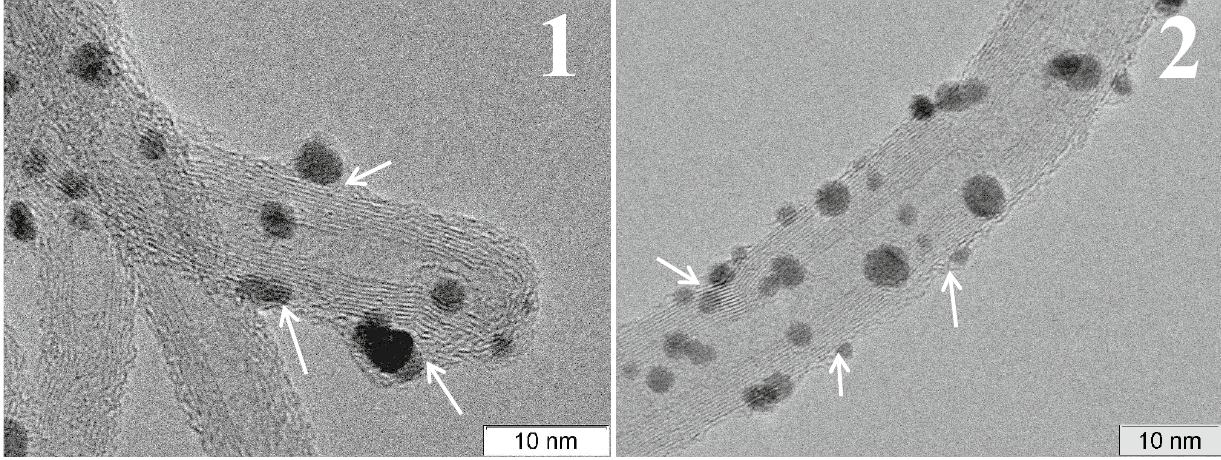
Fig. 4 TEM micrographs with high magnification of the catalysts: Pt/CNT-M (1) and Pt/CNT-MF (2). Arrows show the film of melam (1) and melamine–formaldehyde resin (2). Pt nanoparticles are attached to the modified